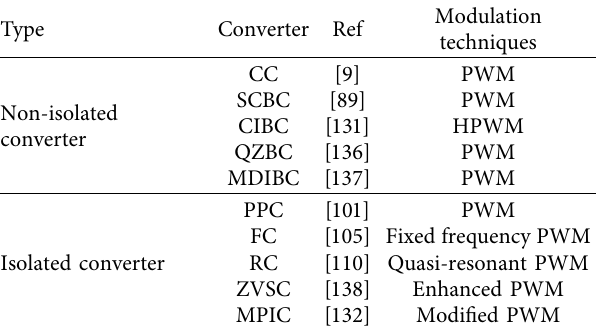
Figure 20: Adaptive neuro-fuzzy system (ANFIS) for EV. Table 3: Literature of different modulation methods in EV converters.